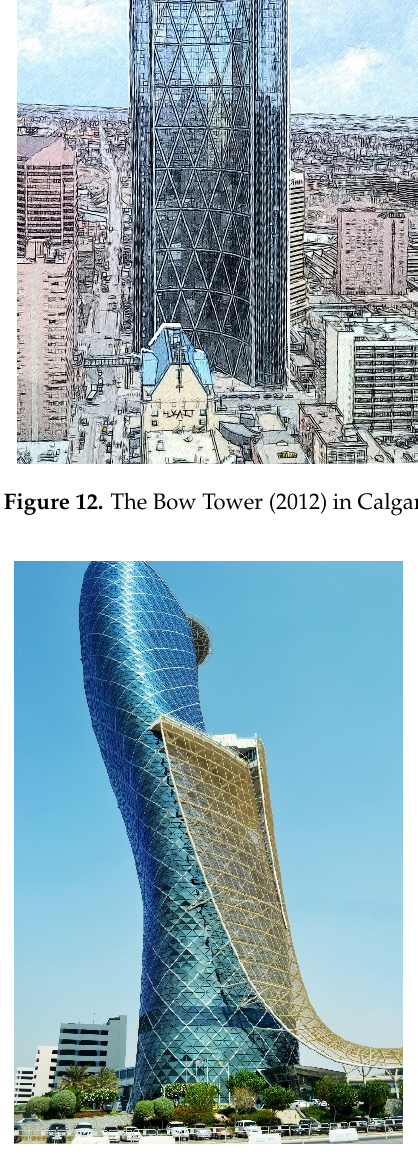
Figure 13. The Capital Gate Building (2011) in Abu Dhabi, UAE. (Photo by K. Al-Kodmany). Different diagonal inclinations generate varying expressions. Overall, shallower an- gles generate denser diagrids that convey heavier systems and vice versa; steeper slopes yield spread-out diagrids that give lighter systems (Figure 14). Different materials for the diagrid system lead to different visual expressions. For example, steel diagrids are likely to communicate high-tech expressions. Steel is expected to suit taller buildings [20]. In some cases, progressively denser diagrids can be employed towards the base of the tall buildings where the loads imposed by the lateral wind forces are the greatest. Figure 14. Variation in the bracing angles leads to different structural performance and diagrid ex- pressions. (Sketch by K. Al-Kodmany; adapted from [23]). Applying diagrids to different building forms leads to various aesthetic expressions. For example, the diagrid system in the Gherkin (30 St Mary Axe) Building in London, UK, generates a dynamic form (Figure 15). Similarly, the diagrid employed in Al Dar Head- quarters in Abu Dhabi, UAE, generates exciting and novel aesthetics (Figure 16). Further, using different colors leads to a variety of visual expressions. For example, the diagrid system of Calgary’s Bow uses a lighter color that contrasts nicely with the darker curtain wall. The NEO Bankside Complex employs warmer colors that convey an inviting resi- dential function. Interestingly, dimmer-color structural systems used in the past century reflected industrial expressions [20]. Examples include One Maritime Plaza (1964) in San Francisco, California, the John Hancock Center (1970) in Chicago, Illinois, and One US Bank Plaza (1976) in Saint Louis, Missouri.